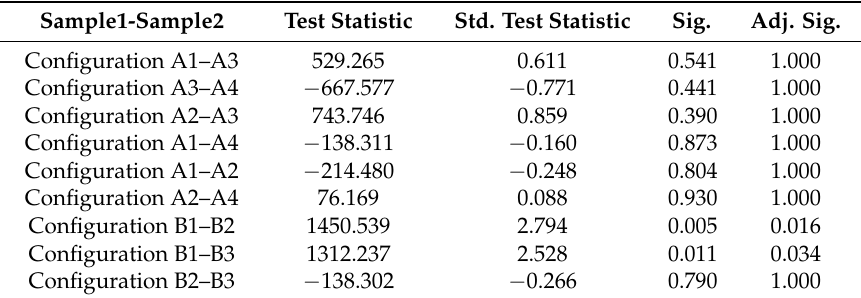
Table 18. Comparison of two configurations under different configurations.